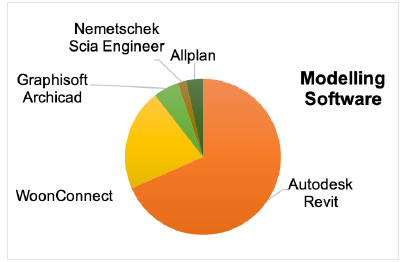
Figure 3. Used Building Information Modelling pieces of software to design and export the models.